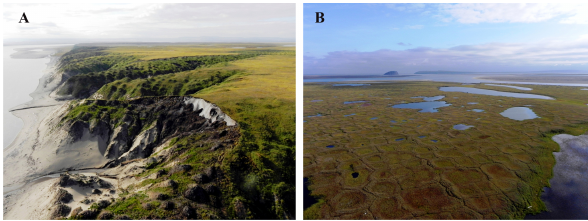
Figure 6. Examples of underrepresented landscapes in the Northern Circumpolar Soil Carbon Database (NCSCD). (A) Yedoma land- scape of Kurungnakh Island. An erosional river cliff with exposed ice-rich sediments. (B) Polygonal tundra of Samoylov Island. Both islands are located in the Lena River Delta in northeastern Siberia. Photos 2010.